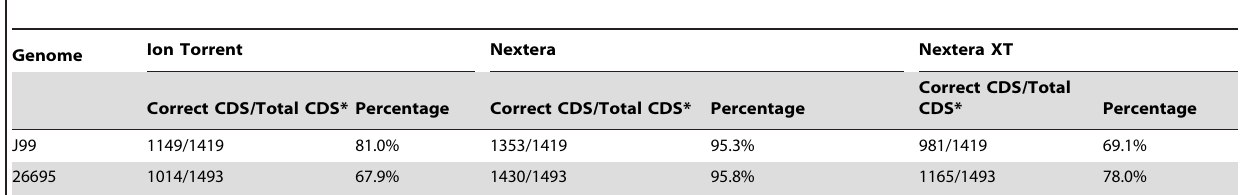
Table 4. Global analysis of coding sequence accuracy of each assembly.